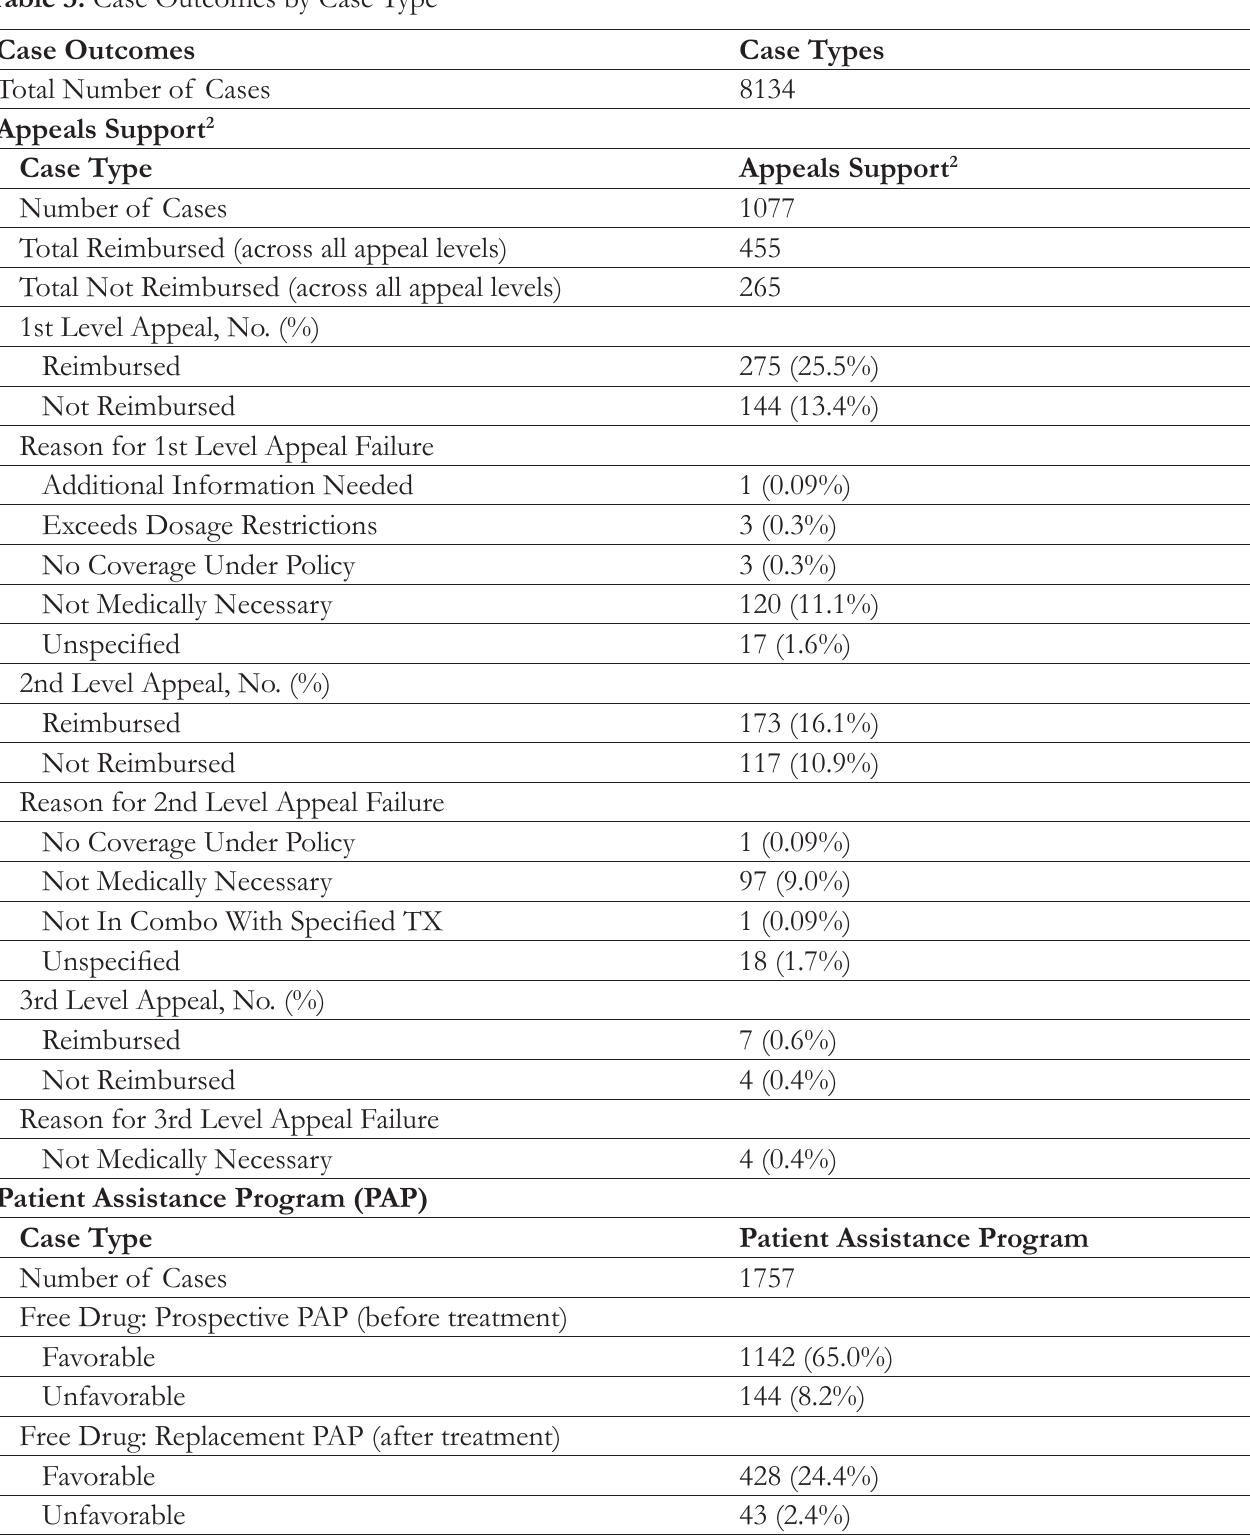
Table 3. Case Outcomes by Case Type 1